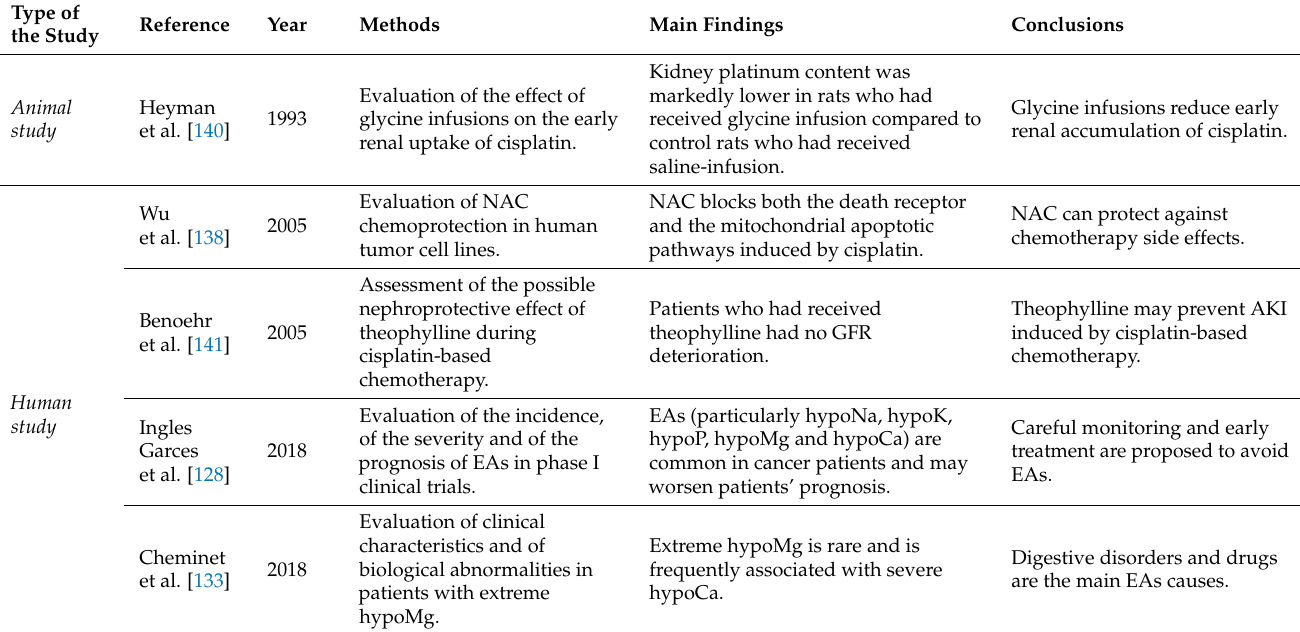
Table 5. Main studies on the electrolyte disorders in